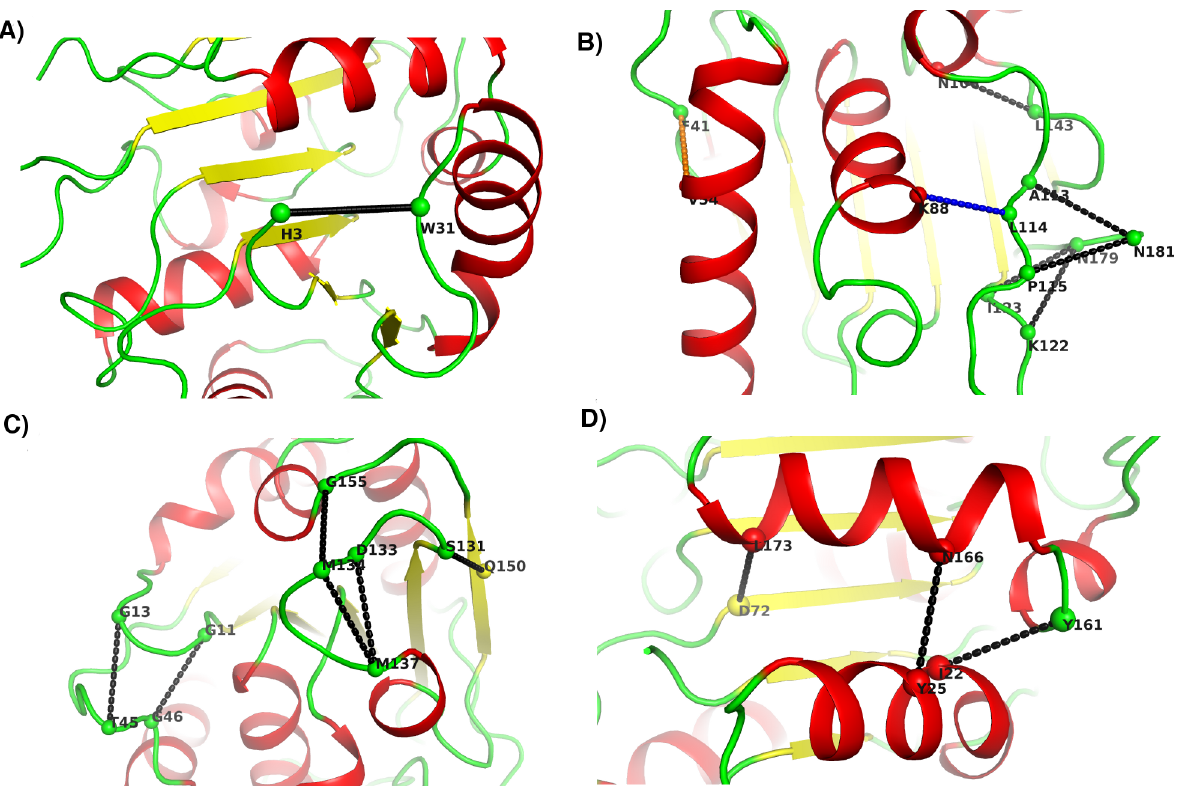
Figure 7. New contacts mapped on the structure of Lipase. Contacts made in the PCN of 6B have been shown on the tertiary structure of the Lipase. A) Contact between W31 and H3 stabilizing the N terminus; B) Contacts stabilizing the C-terminus (shown in Black) and loop (shown in Blue and Orange); C) Contacts near active site (active site residues given in Table 1) and D) Contacts joining two secondary structures.